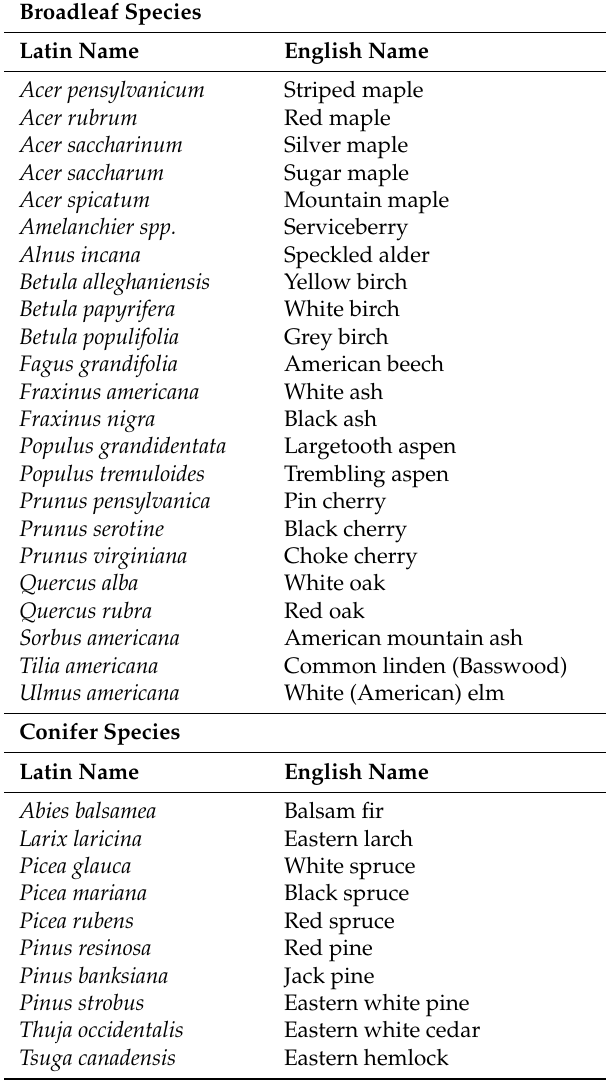
Table A1. Complete List of Acadian Tree Species